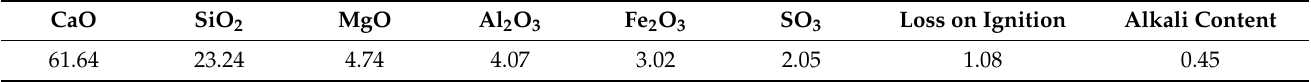
Table 3. Chemical compositions of LHP cement (% by mass).